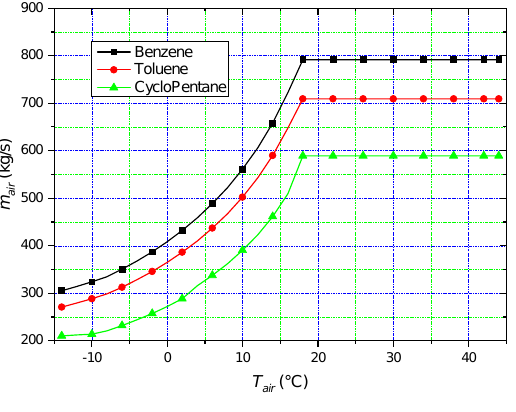
Figure 6. Condenser air mass flow rate varying ambient temperature.